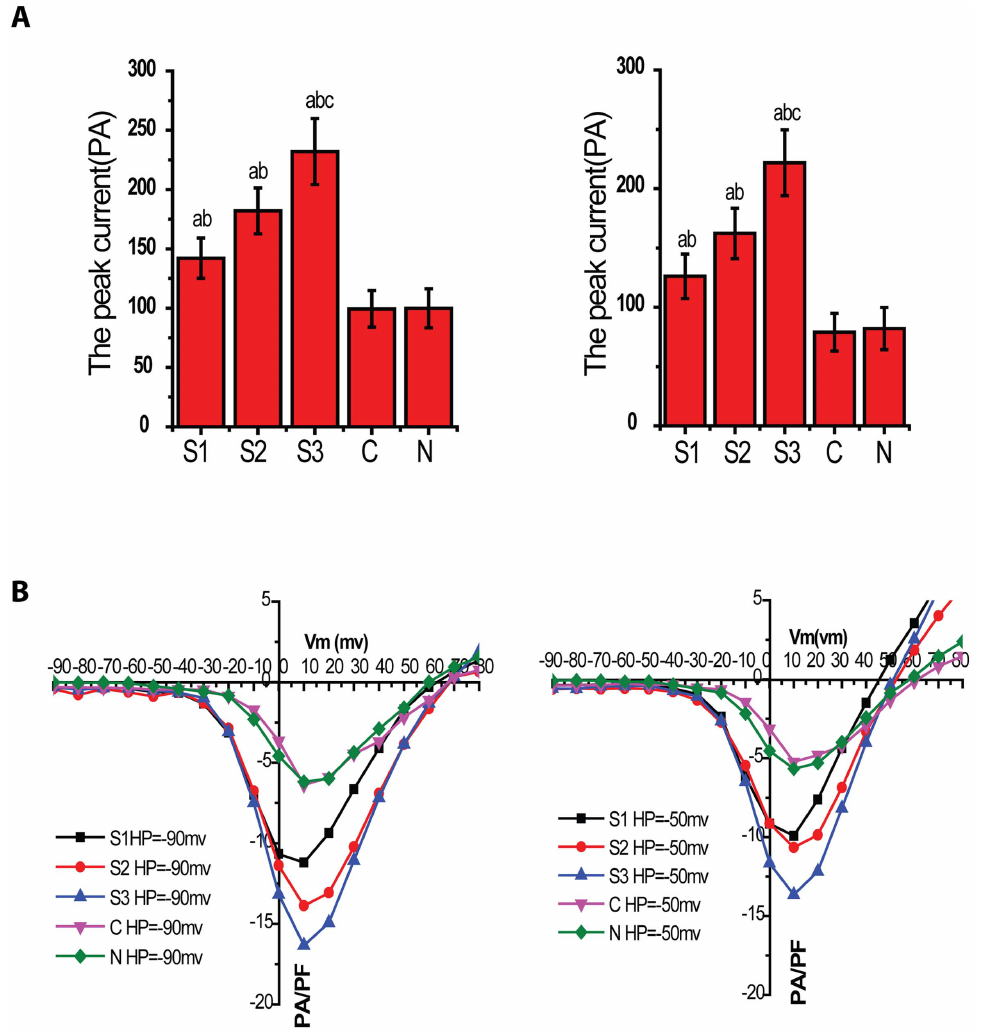
Figure 2. Activation curve of VDCCs in rabbit basilar artery smooth muscle cells after SAH. The graph A and B showed I-V plot at HP of 2 90mv and 2 50mv respectively. The ordinate was currents density (pA/pF) and the abscissa was voltage (mV). The two I-V plots showed the current density of VDCCs in S1–S3 group, which was bigger than that in N and C group at HP of 2 90mV and 2 50mV (P , 0.05, n=8/group). The current density in S3 group was bigger than those in S1 and S2 group (P , 0.05, n=8/group).The current density was not significantly different between C and N group (P . 0.05, n=8/group).